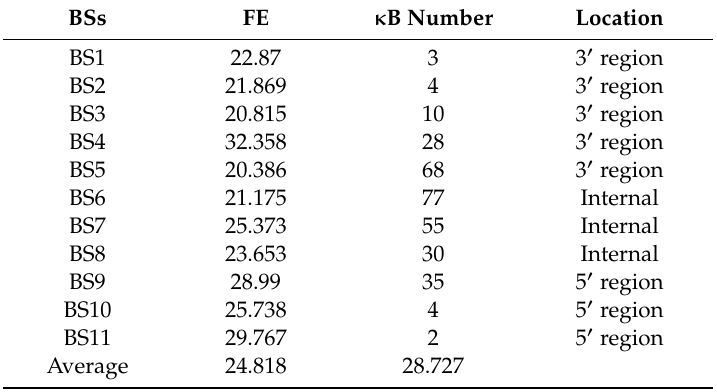
Table 2. NF- κ B-BSs assigned to miR1276 / KLHL25 and their κ B